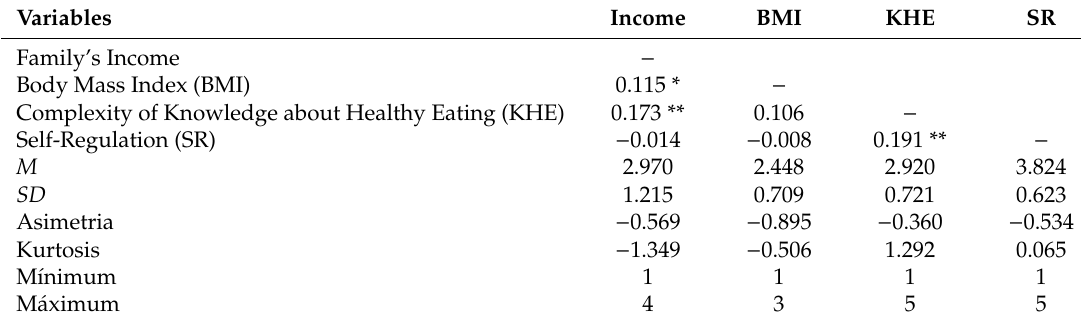
Table 2. Descriptive statistics and Pearson correlation